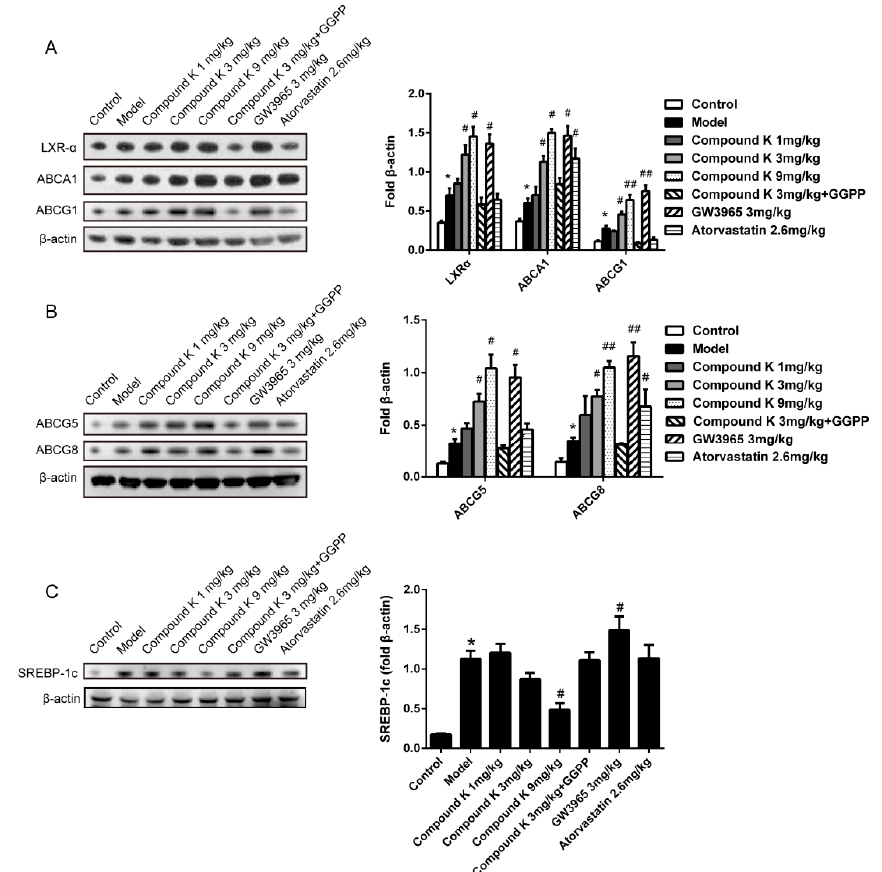
Figure 4. Compound K promotes the expression of reverse cholesterol transport (RCT) related proteins. Levels of LXR α , ABCA1 and ABCG1 in aorta ( A ); ABCG5 and ABCG8 in intestine ( B ); and SREBP-1c ( C ) in liver were detected by immunoblotting and normalized to β -actin. Different from GW3965, treatment of compound K could significantly reduce the expression of SREBP-1c. Data are presented as mean ± SEM ( n = 6) and analysed by ANOVA with Dunnett’s post-hoc analysis. * p < 0.05 vs. control; # p < 0.05 vs. model; ## p < 0.01 vs. model.